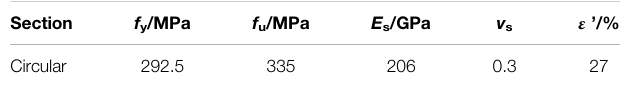
TABLE 2 | Measured material properties of the steel tube.